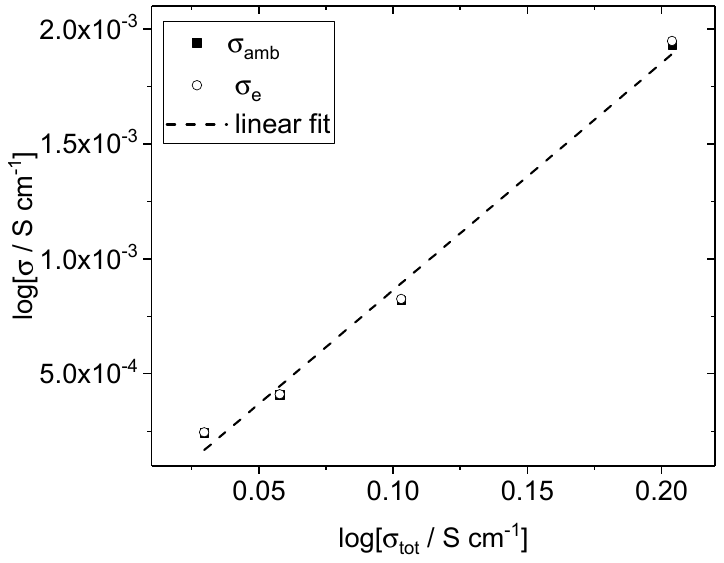
Figure 9. Electronic conductivity calculated via Equations (6) and (7) as function of electrical conductivity determined by impedance spectroscopy.